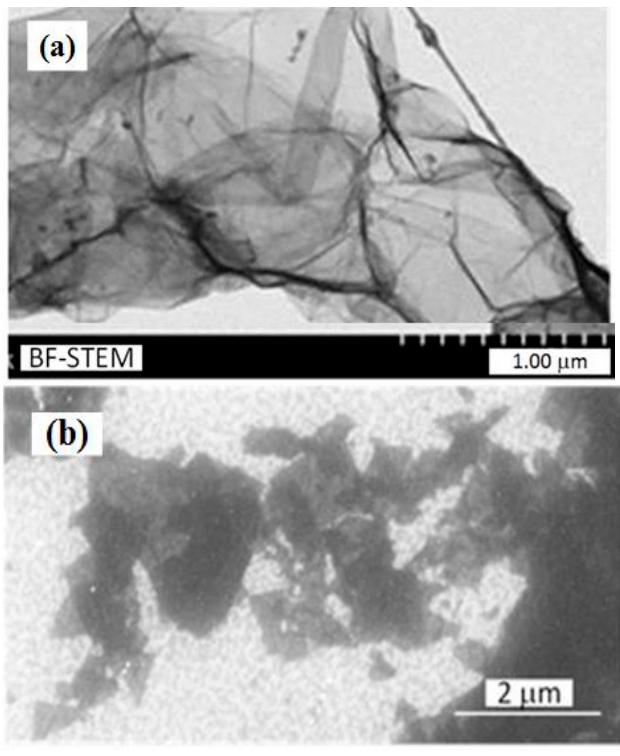
Figure 2. ( a ) TEM and ( b ) SEM image of GO flakes. In the image of GO/Fe 2 O 3 nanostructure, Figure 3a, one can see both gray areas of GO flakes and white spots of Fe 2 O 3 nanoparticles of average dimension ca 100 nm, covering GO flakes. The XRD patterns, Figure 3b, were obtained by using an XRD diffractometer Bruker AXS D8 Advance Cr (K α 2.2910 Å) (Bruker AXS GmbH, Karlsruhe, Germany) with vanadium filter 0.015 mm. Observed peaks belong to the crystal planes of the hematite phase, which can be indexed to the rhombohedral structure of α -Fe 2 O 3 and their positions are in accordance with JCPDS 86-0550 card. Analysis of the X-ray reflectivity for GO/Fe 2 O 3 nanostructure enabled the determination of its thickness, equal 47.5 nm, and the RMS of surface roughness, 1.42